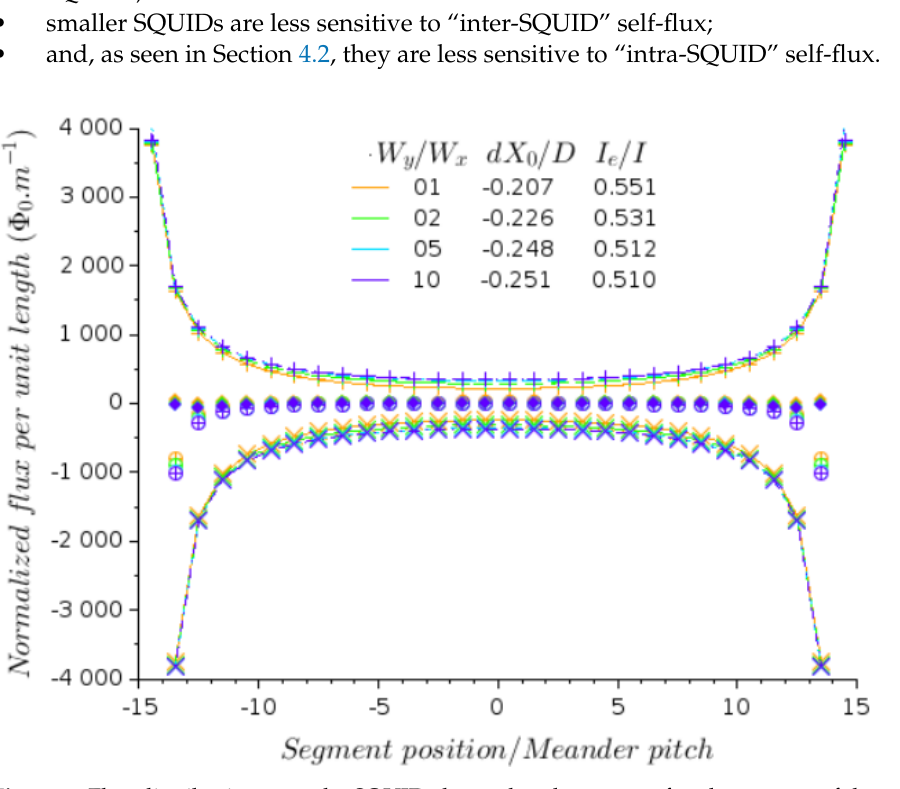
Figure 6. Flux distribution over the SQUIDs located at the center of each segment of the meander geometry for a bias current I = 100 µ A . The flux per unit length is normalized by the flux quantum Φ 0 . The symbols refer to different configurations of the edge segments: (+) containing SQUIDs as all the other segments (same as Figure 5); ( × ) no SQUID on edge segments, and I e = 0; ( ⊕ ) no SQUID on edge segments, and I e as indicated in the table as inset; ( (cid:5) ) idem, but edge segments are shifted by dX 0 as indicated in the table as